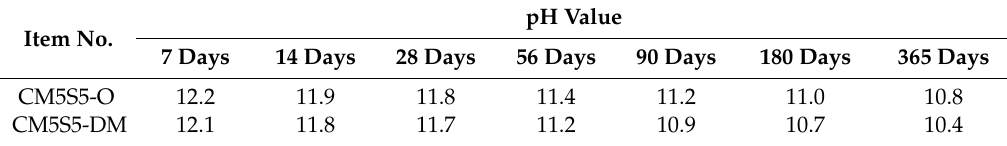
Table 10. pH values of marble-based geopolymer concrete.